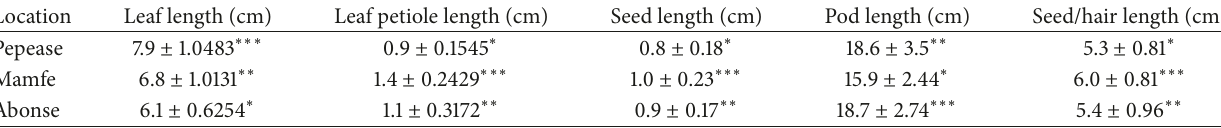
Table 3: Mean dimensions of the leaf, seed, petiole, and pod indices of C. sanguinolenta (adapted from Ameyaw [31]).